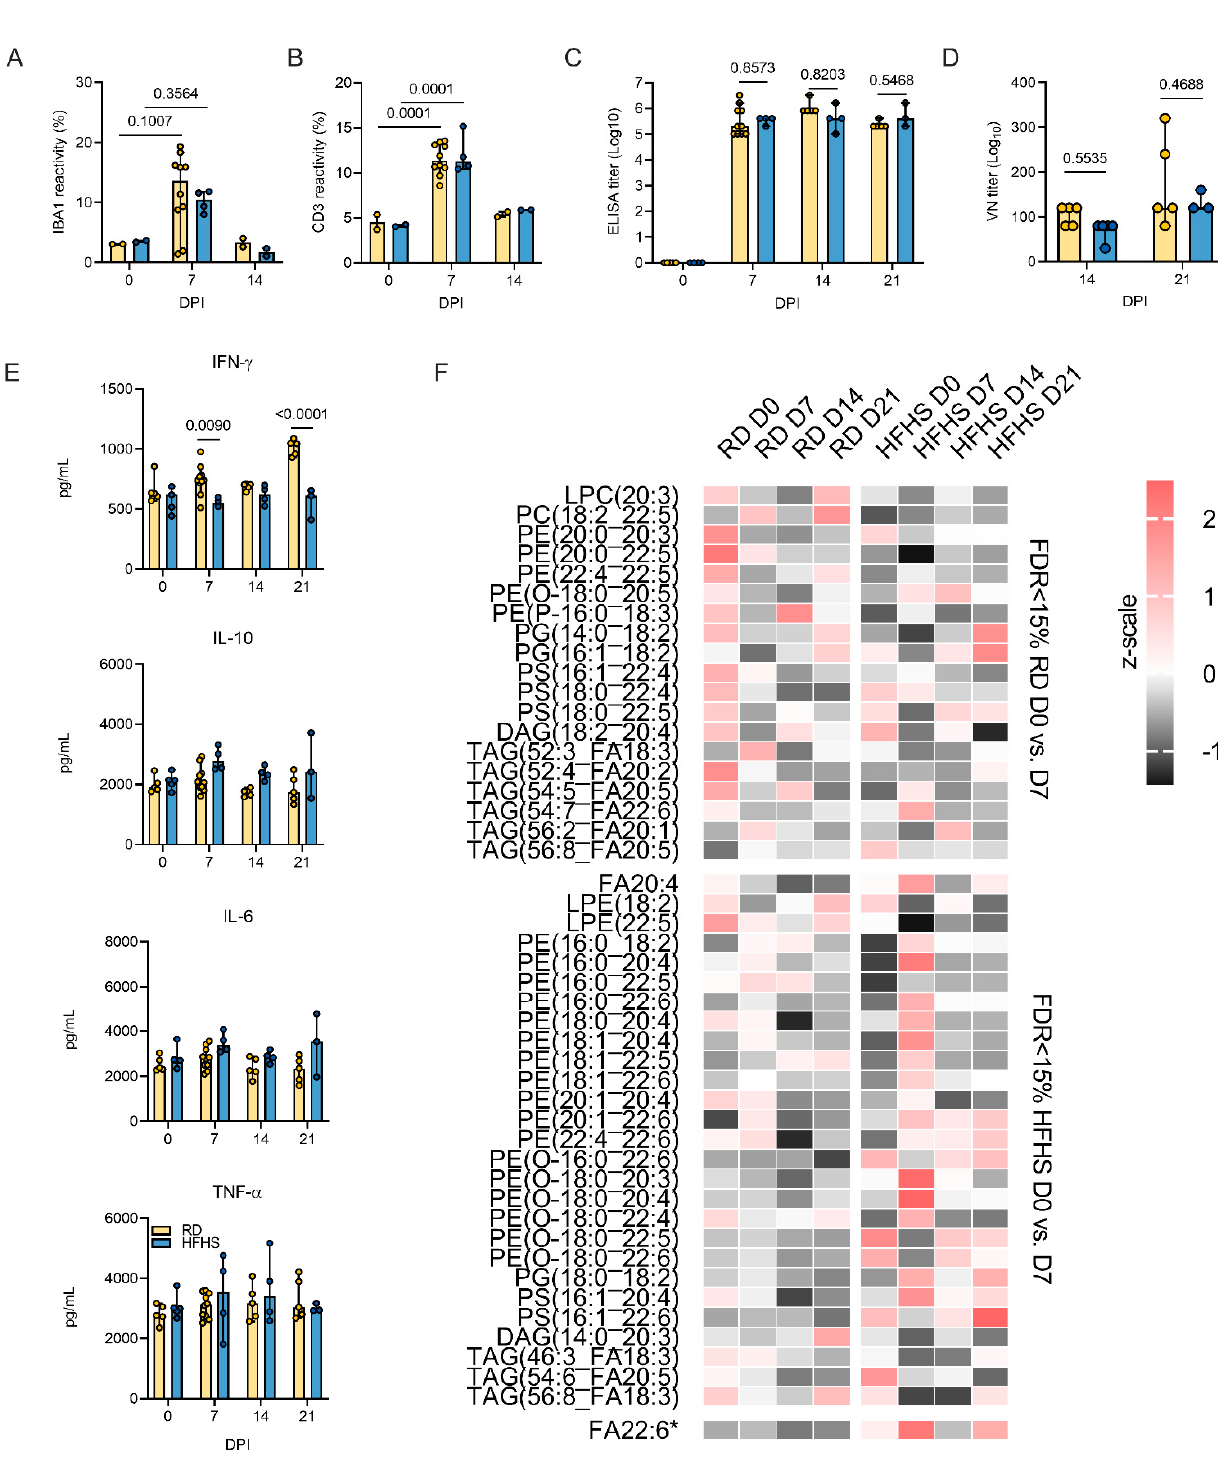
Figure 6. Disease manifestation is accompanied by prolonged viral shedding, systemic immune and metabolomic dysregulation after high-fat high-sugar diet. Animals were euthanized pre-challenge, at 7, 14, and 21 DPI with SARS-CoV-2 and serum and lung tissue collected for immune and lipid mediator analyses. ( A , B ) Lung infiltration of T-cells (CD3) and macrophages (IBA1) was quantified by morphometric analysis. Bar chart depicting median, 95% CI and individuals, pre-challenge and 14 DPI: n = 2, 7 DPI: n = 10 (RD)/4 (HFHS), ordinary two-way ANOVA, followed by Tukey’s multiple comparisons test. ( C ) ELISA titers against spike protein of SARS-CoV-2 (lineage A) in serum obtained pre-challenge, at 7, 14, and 21 DPI. Bar chart depicting median, 95% CI and individuals, pre-challenge and 14 DPI: n = 5 (RD)/4 (HFHS), 7 DPI: n = 10 (RD)/4 (HFHS), 21 DPI: n = 5 (RD)/3 (HFHS), ordinary two-way ANOVA, followed by Sidak’s multiple comparisons